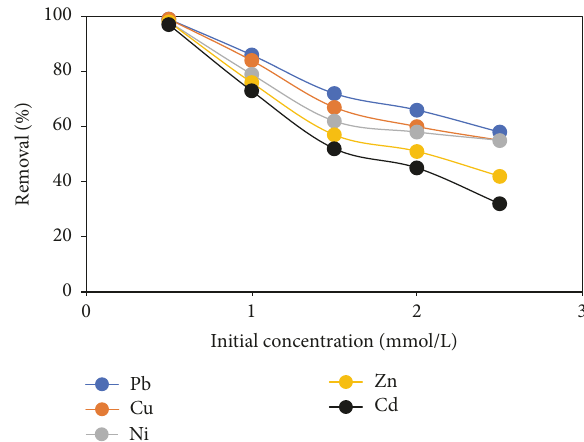
Figure 10: Effect of initial concentration on percentage removal of heavy metal ions by FGCX (conditions: 6g/l FGCX; pH: Pb = 5, Cu = 5, Ni = 7, Zn = 6, and Cd = 6; contact time: 60min; agitation speed: 120 rpm; temperature: 45 ∘ C).